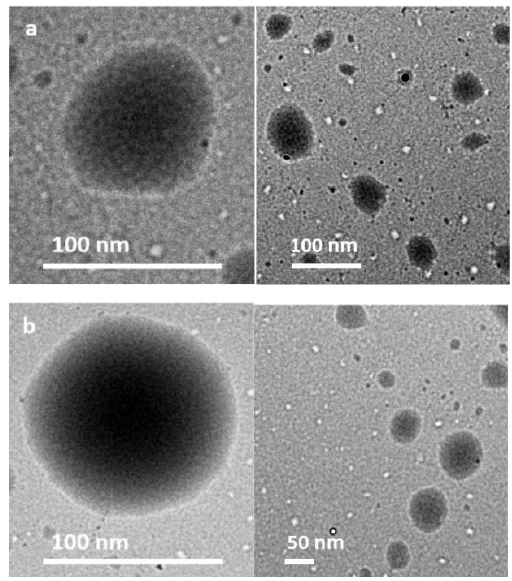
Figure 3. Images of transmission electron microscopy (TEM) at high ( left ) and low ( right ) magnification of ( a ) NCS20 and ( b ) NCP50 samples. The contrast between the core and the shell of the particle confirms the formation of the nanocapsules. NCS20 is composed of 90% of surfactant and 10% of type II resins, and the NCP50 is distributed by 94% of Petro 50 surfactant and 6% of type II resins.